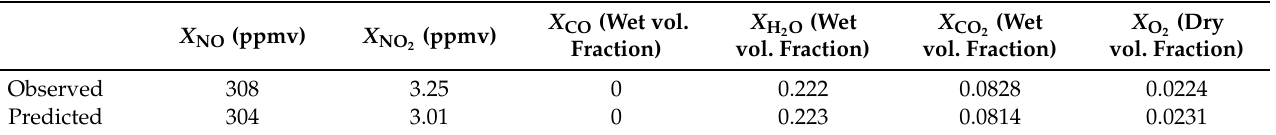
Figure 5. Comparison between the predicted and observed temperature field ( a ); CH ∗ field ( b ); and OH ∗ field ( c ) for case 2. Table 3. Observed and predicted species emissions for case